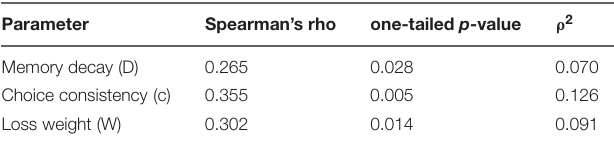
TABLE 7 | Correlations for parameters of the PVL2 model estimated from the IGT and SGT. Parameter Spearman’s rho one-tailed p -value ρ 2 Memory decay (D)